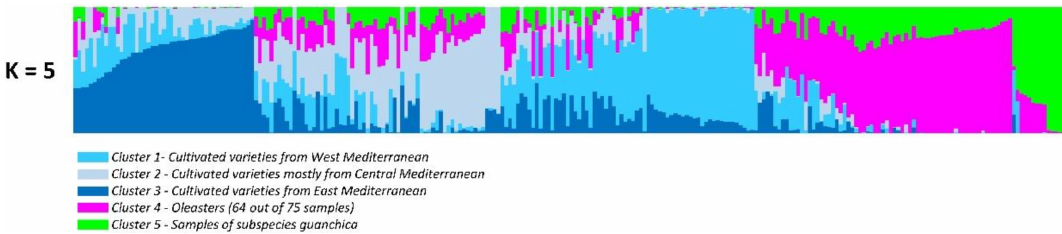
Figure 2. Estimate of genetic diversity of 260 Olea europaea accessions analyzed by 1040 SNP markers. Bar-plot describes the population structure estimated by the Bayesian clustering. According to the most informative K values, five clusters were distinguished. Each individual was represented by a horizontal colored line, with a length proportional to the estimated membership coe ffi cient.